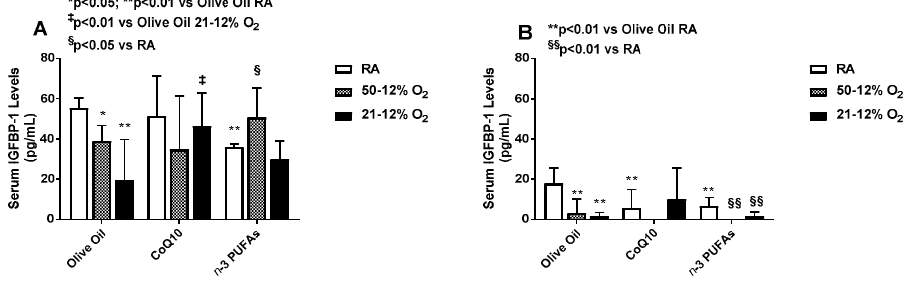
Figure 5. Effects of neonatal IH with Co-Q10 or n -3 PUFA supplementation on serum insulin-like growth factor binding protein-1 levels. Panel ( A ) represents treatment during IH exposure and supplementation for 14 days, and panel ( B ) represents recovery from IH (IHR) in room air (RA) with no treatment. Groups are as described in Figure 2. Data are expressed as mean ± SD ( n = 8 samples/group).